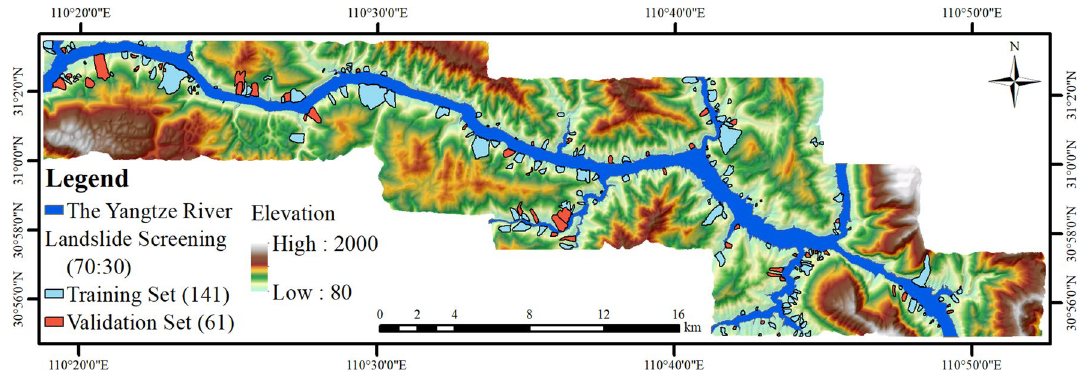
Figure 9. Random division result of landslides sample set in study